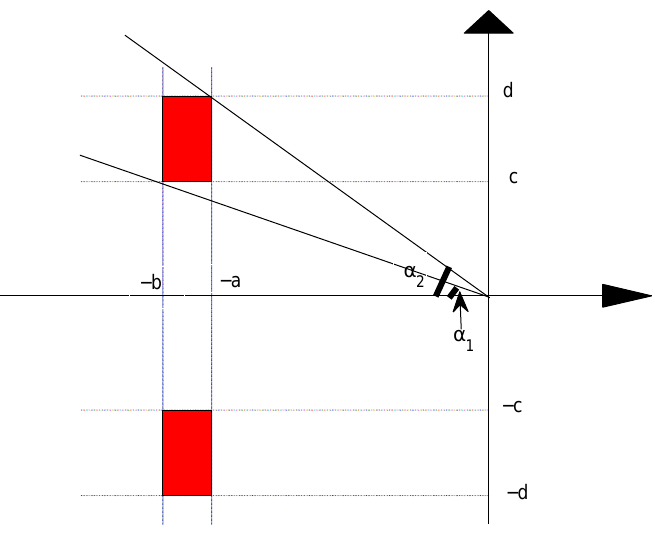
Figure 1. Rectangle region ( − b , − a ) × ( c , d ) and ( − b , − a ) × ( − c , − d )